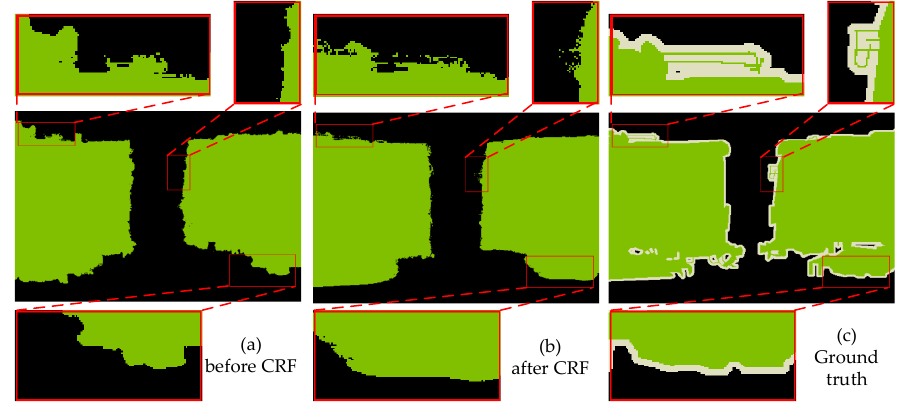
Figure 6. Accurate boundary recovery and partial enlarged details.